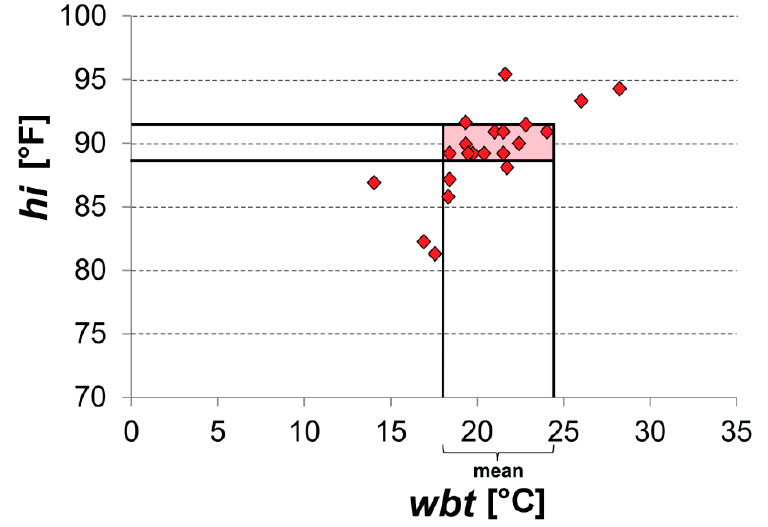
Figure 2. Exemplary Swiss-wide threshold calculation for wet bulb temperature ( wbt ) on the basis of 88 °F < hi < 92 °F. The markers represent virtual wbt and heat index ( hi ) pairs for all stations together.